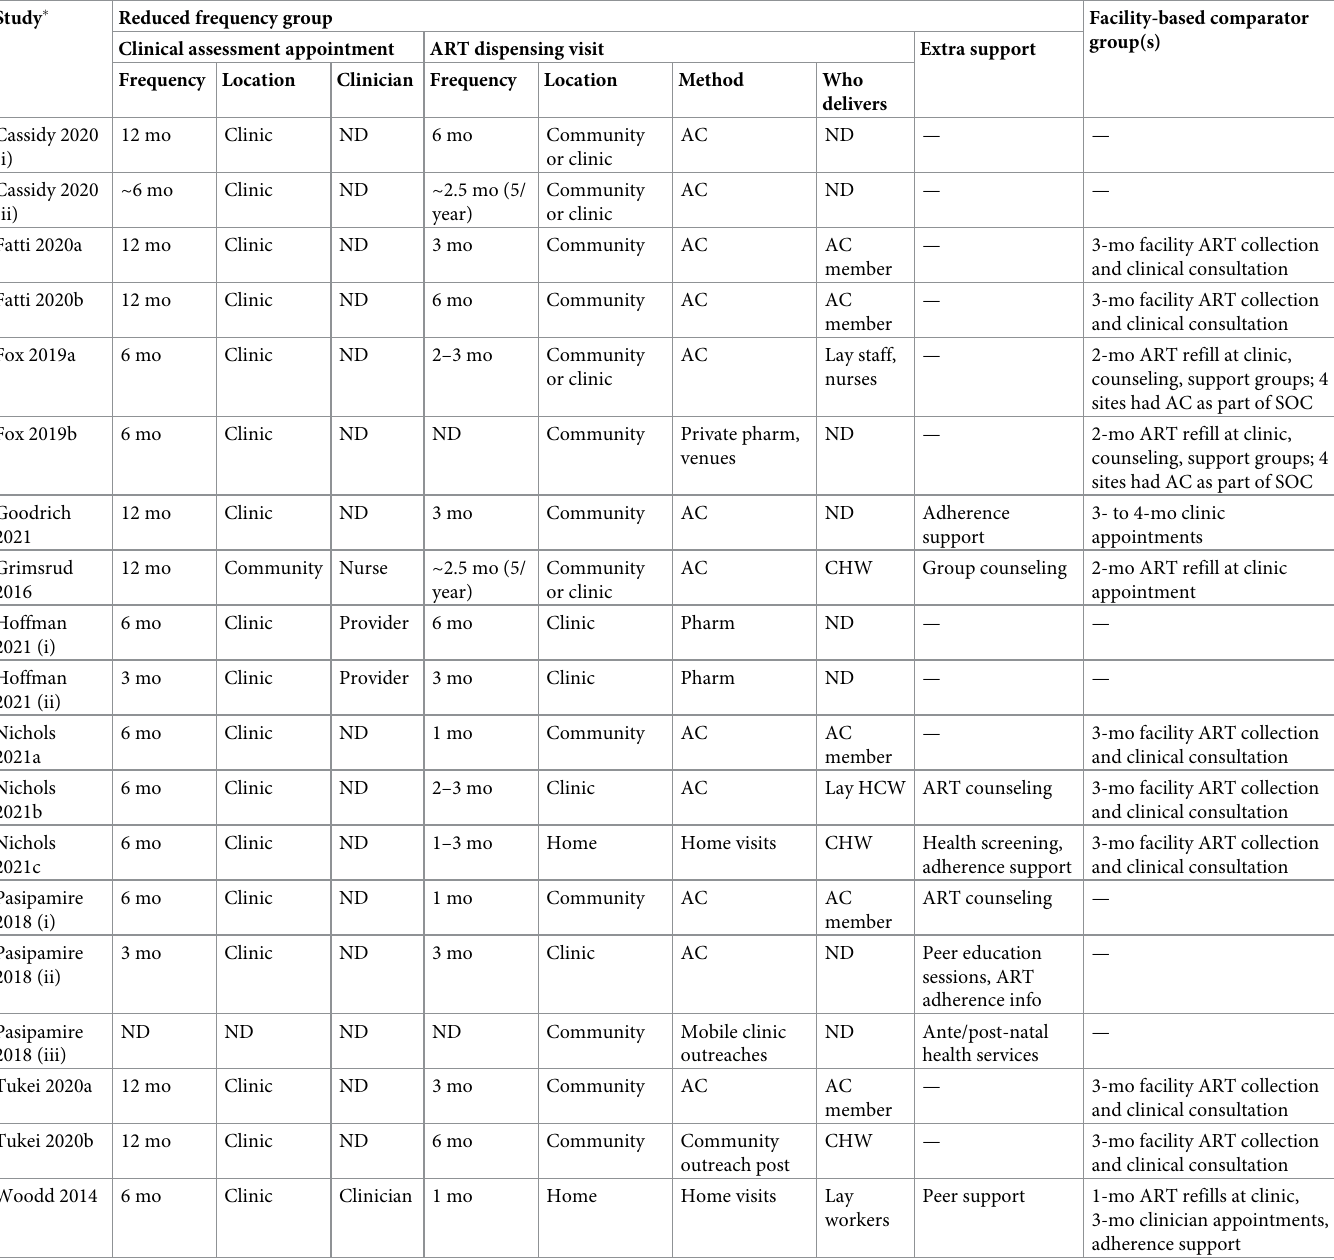
Table 3. Summary of intervention